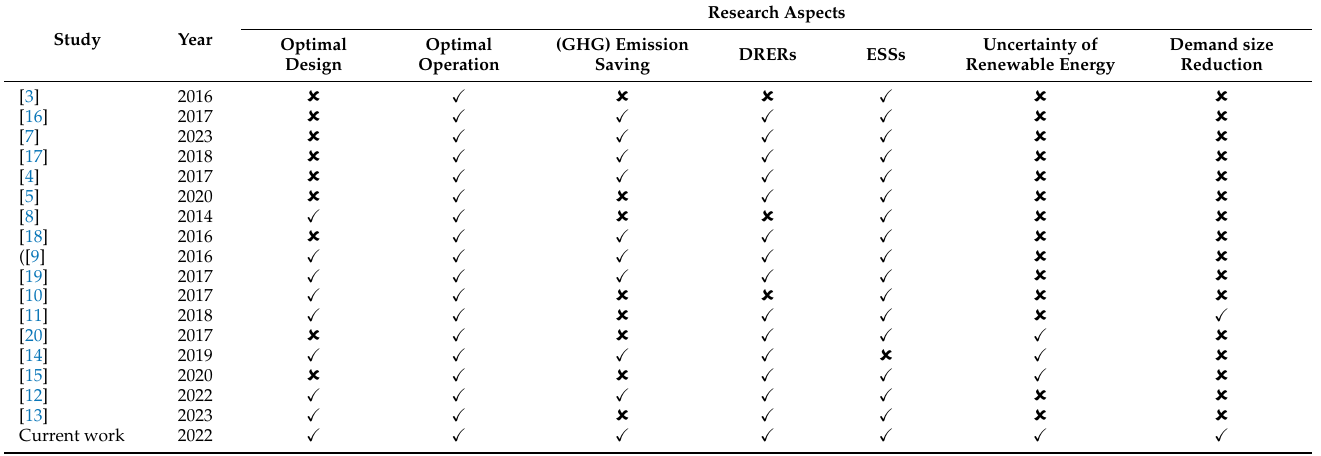
Table 1. Literature review summary on energy hub optimization problems, the research gap, and the current research contribution.